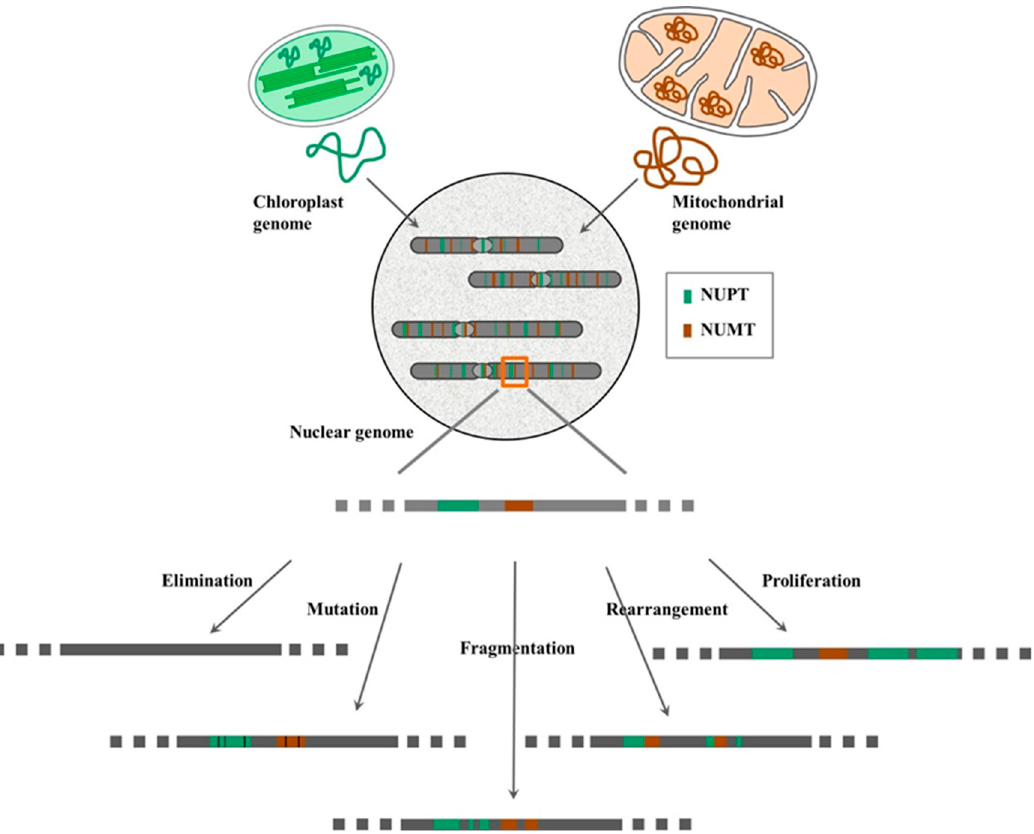
Figure 2. Diagrammatic sketch summarizing the fate of integrated organellar DNA in nuclear genome. See details in